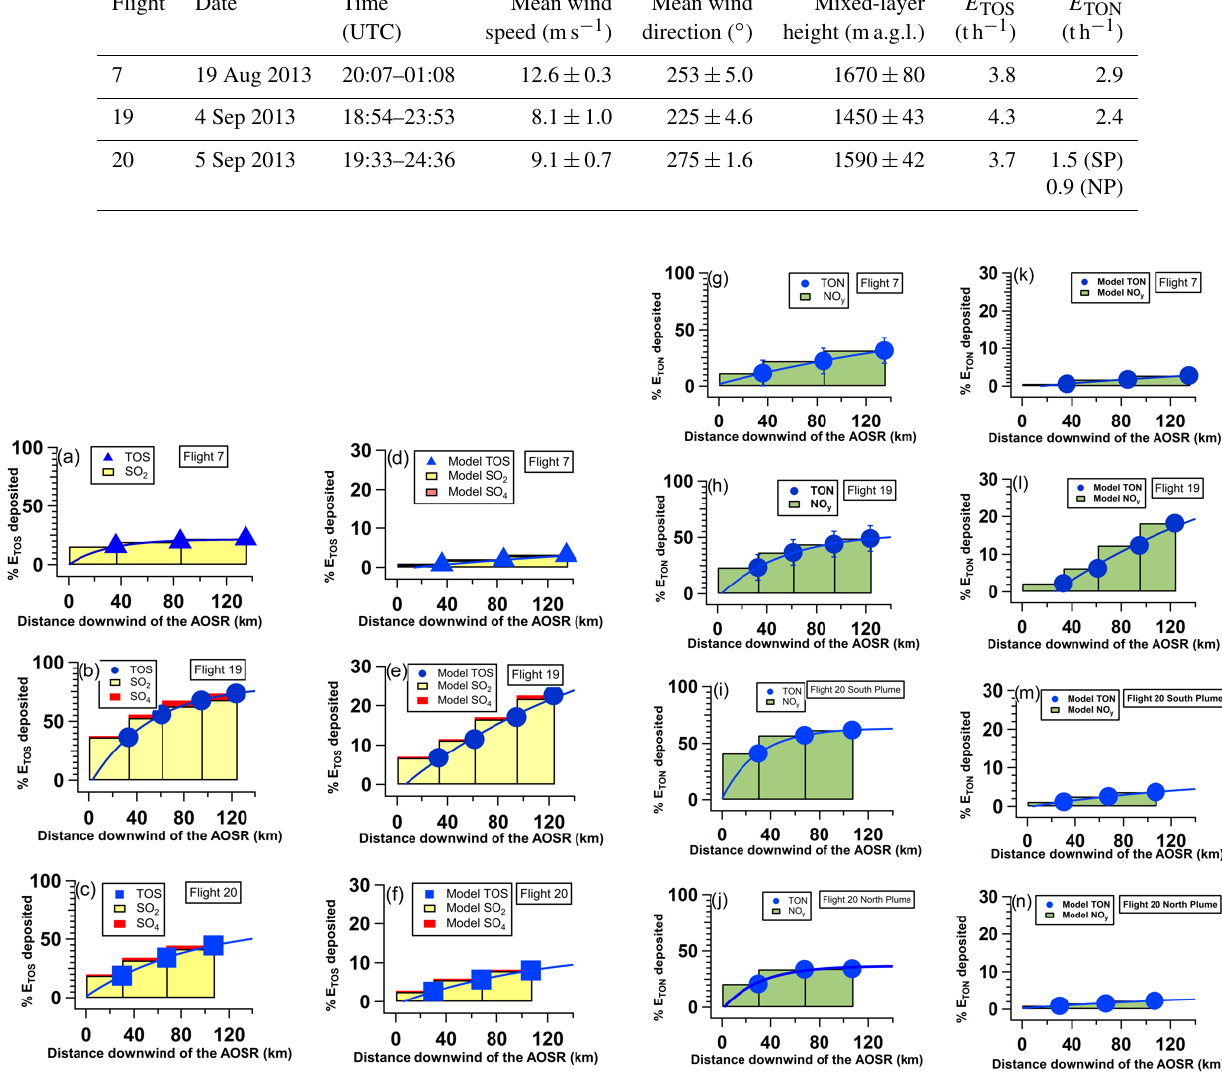
Figure 3. Cumulative dry deposition as a percentage of emissions E TOS ( a to f ) or E TON ( g to n ) for F7, F19 and F20 measurements with corresponding GEM-MACH model predictions. The bars show the dry deposition due to SO 2 and p SO 4 . The curves were fitted to the TOS and TON dry deposition percentages from which d 1 /e and τ were